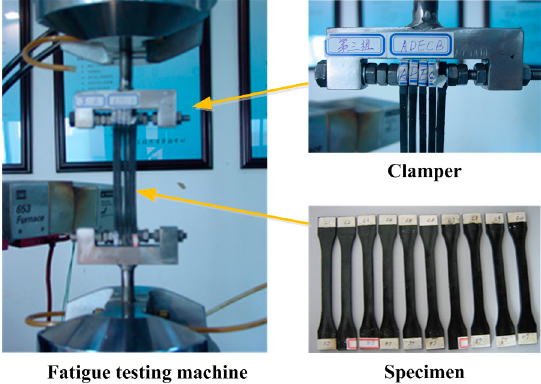
Figure 2. HDPE Fatigue test sample dimensions.